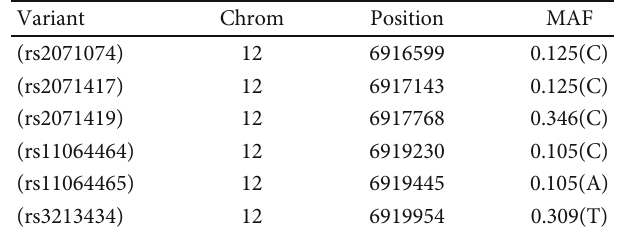
Table 1: Physical locations of the 6 NSE gene